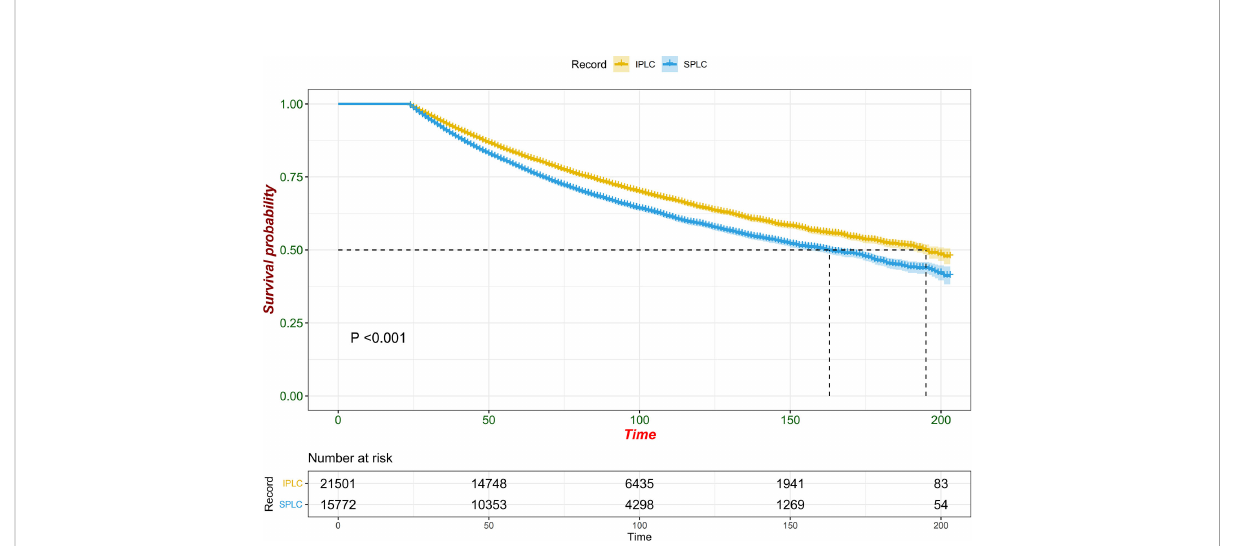
FIGURE 2 Forest plot of association between survival and SPLC diagnosis (vs. IPLC) in multivariable cox